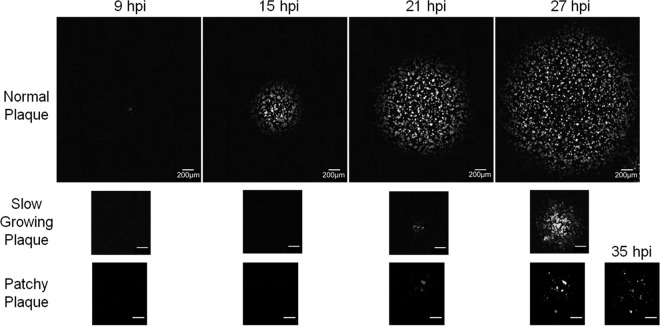
Spread patterns in the presence and absence of DIPs. Representative time lapse images of three major spread patterns on BHK-21 cells infected with reporter VSV at an MOI of 30 and their DIPs at various multiplicities are shown. Bars, 200 μm. Normal plaques (top) emerged from cells infected at all MODIP levels, but primarily at a MODIP of 0 or a low MODIP (0.1 or 1). Slow-growing (center) and patchy (bottom) plaques were observed only in the presence of DIPs (MODIP levels, 1 and 10). Time points are shown above the panels. Since the patchy plaques developed more slowly than the others, an additional image at 35 hpi is shown. See also Movies S1 to S3 in the supplemental material.